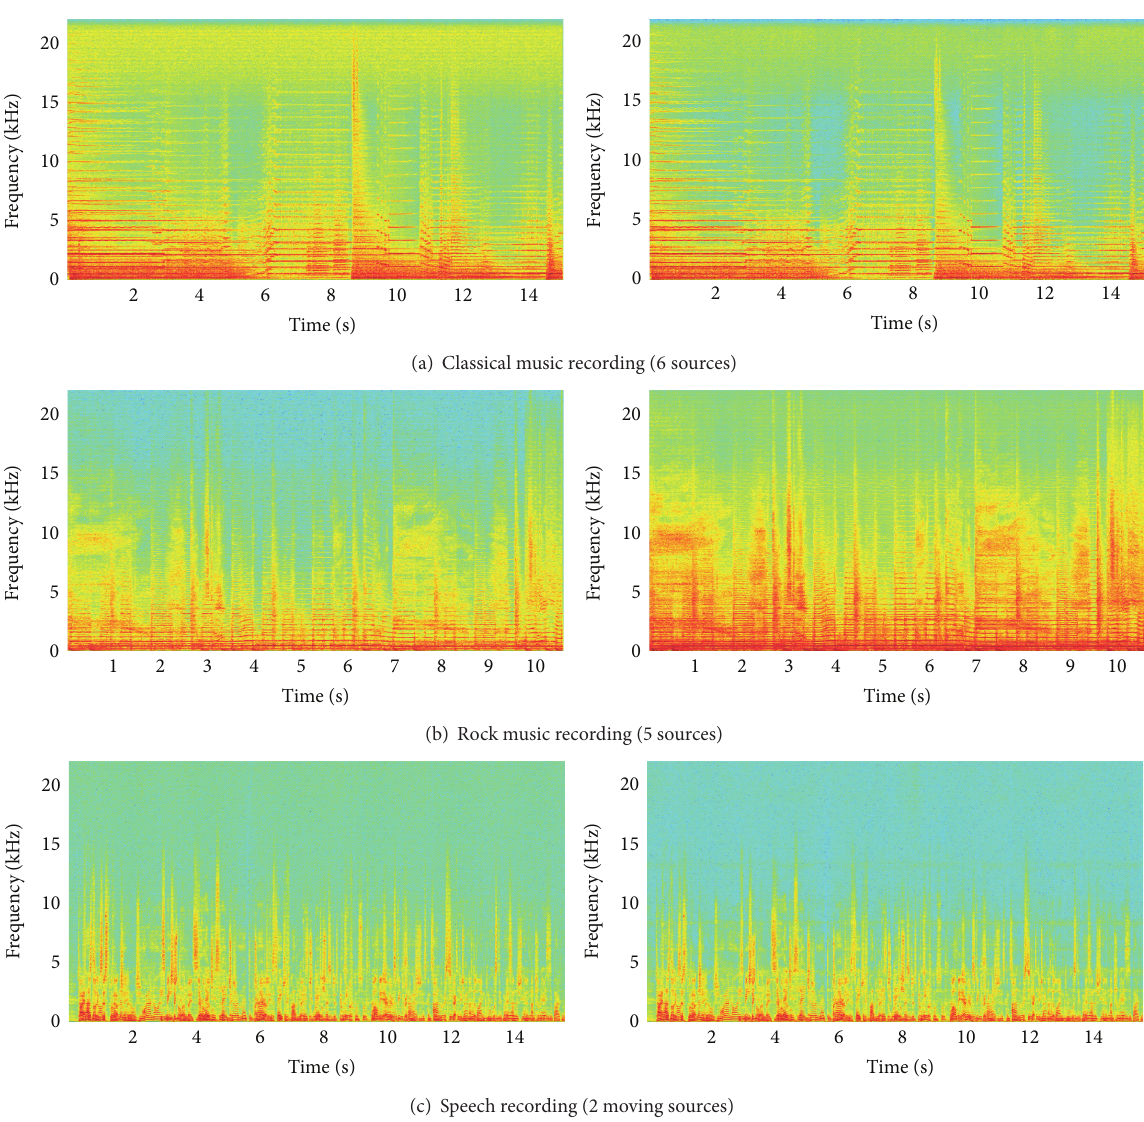
Figure 6: Spectrogram of (left column) the signal at the first microphone of the array and (right column) the downmixed signal for the simulated